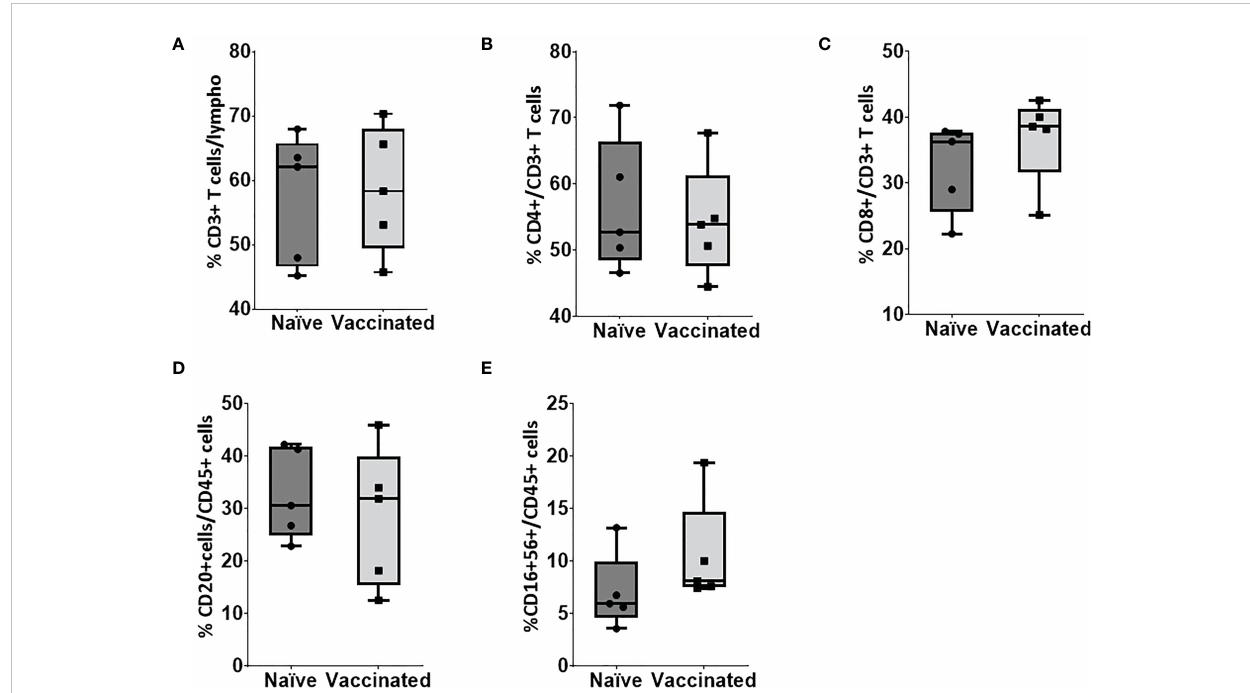
FIGURE 3 Flow cytometry analysis of lymphocyte subsets in peripheral blood. Blood samples of naïve (n = 5) and vaccinated monkey groups were surfaced stained with appropriate antibodies and analyzed using fl ow cytometry. Lymphocytes were gated based on forward and side scatter, and (A) CD3+ and CD45+ cells were gated on lymphocytes. (B) CD4+ and (C) CD8+ cells were gated on CD3+ cells whereas (D) B cells and (E) natural killer (NK) were gated on CD45+ cells. Horizontal lines indicate mean